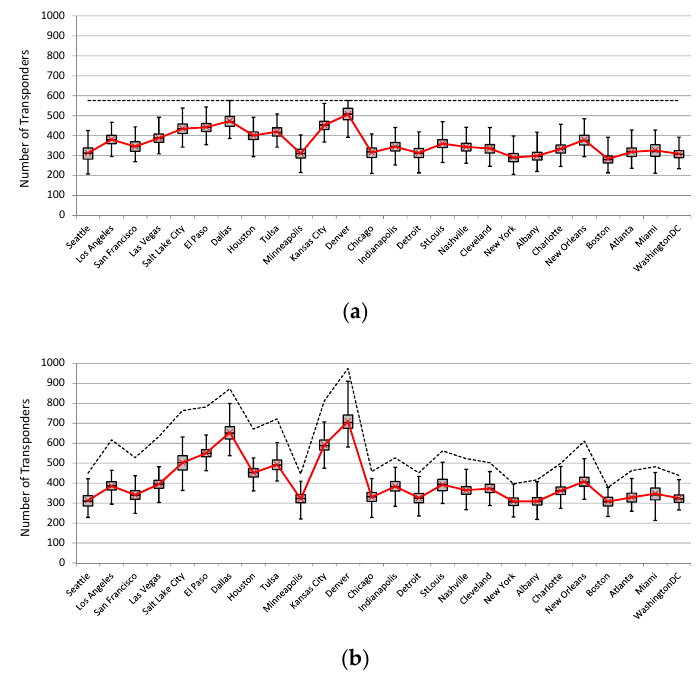
Figure 14. Box graph with placement of transponders given by: ( a ) UNI and ( b ) SAUR algorithms, for the US26 network, TP A, and 15,000 transponders. The dotted line shows the number of transponders in each node according to a particular algorithm. The red line represents the average observed values of transponder usage, while the boxes show data through their quartiles.